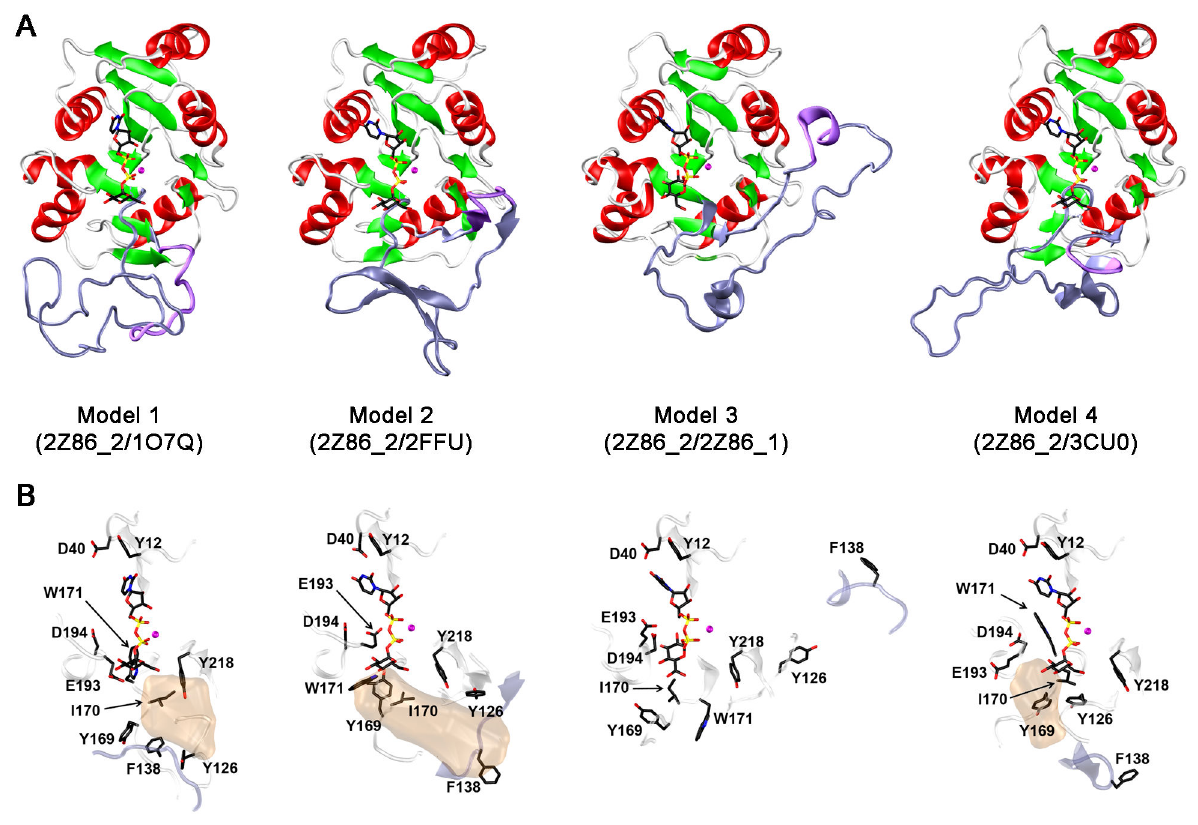
Figure 5. Structural models for GT MG517 (aa 1-220). A) The four models were generated using the 3D structure of E. coli chondroitin polymerase domain 2 (PDB 2Z86) as template for the conserved region (aa 1-121 and 174-220) and four different structures as templates for the variable region (aa 122 to 173, shown in blue). The PDB accession codes for the template structures are given in parenthesis. B) Location of the selected amino acid residues analyzed by site-directed mutagenesis (Table 2) in the four structural models. Filled volume represents the acceptor site in the original templates (except for model 3 where no ligand was present). Coordinate files of the models are available upon